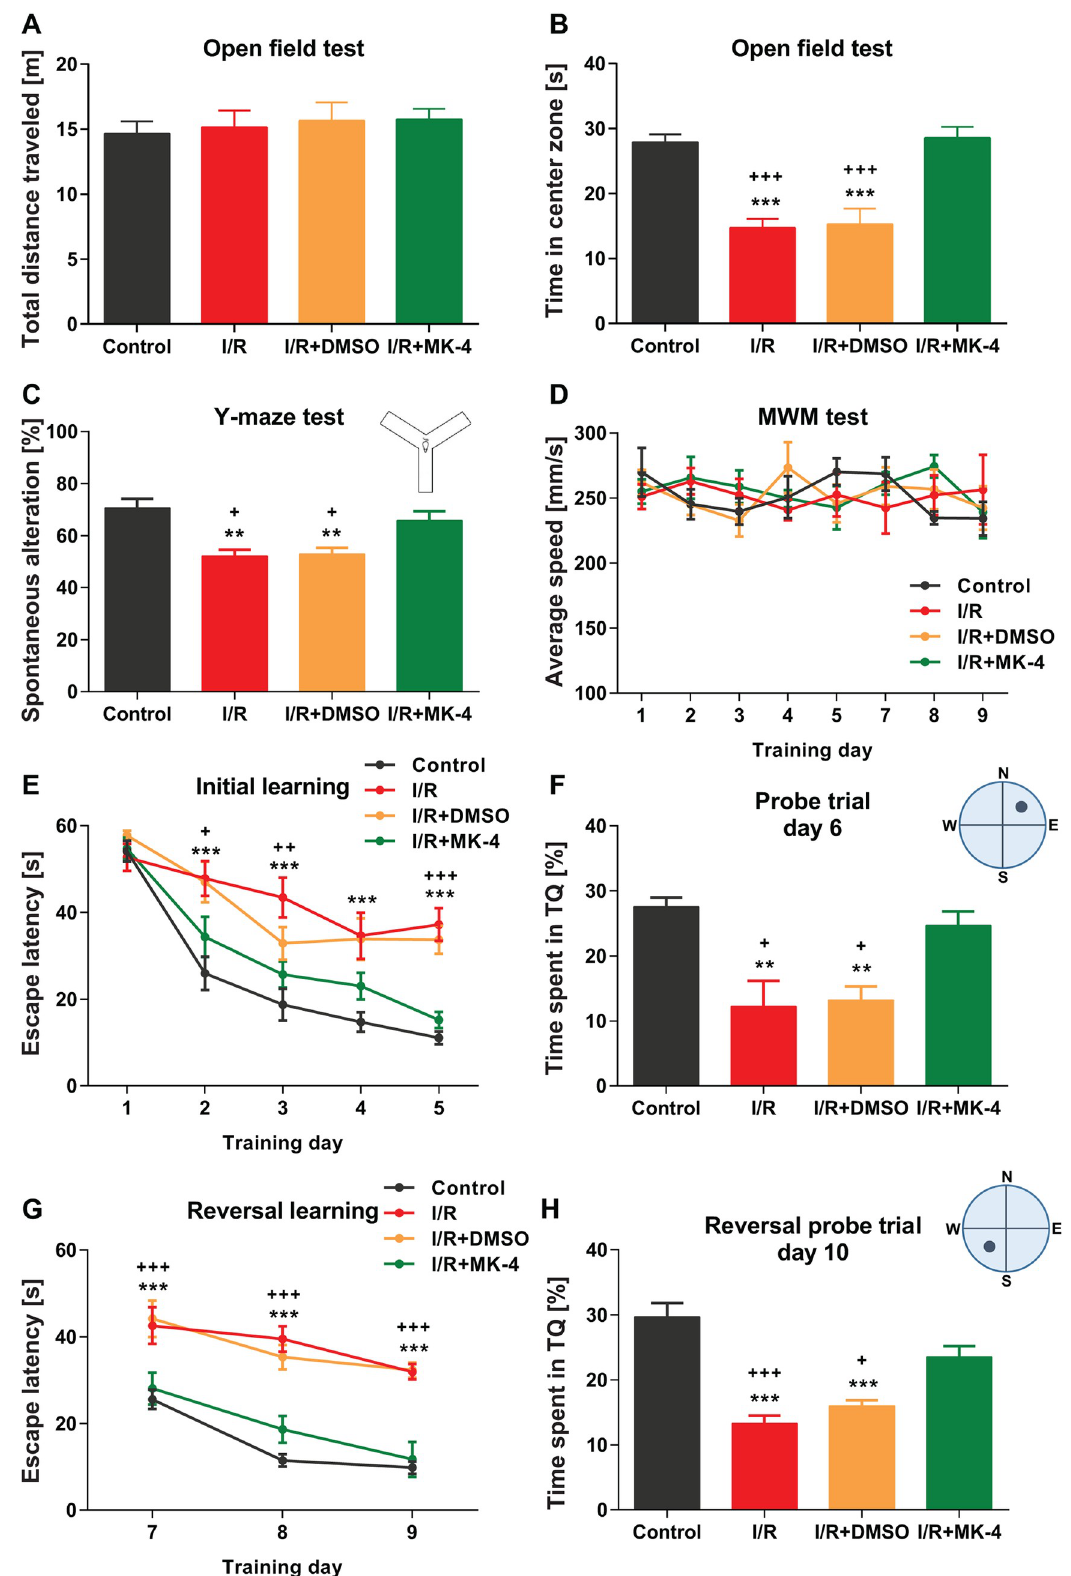
Fig 3. The positive effects of MK-4 administration on behavioral deficits induced by I/R injury. (A) In the open field test, total distance traveled was not changed significantly following I/R injury induction. (B) Time spent in the center zone of open field arena was reduced post I/R, however, i.p. administration of 400 mg/kg MK-4 (200 mg/kg immediately and 2 h after I/R injury) led to